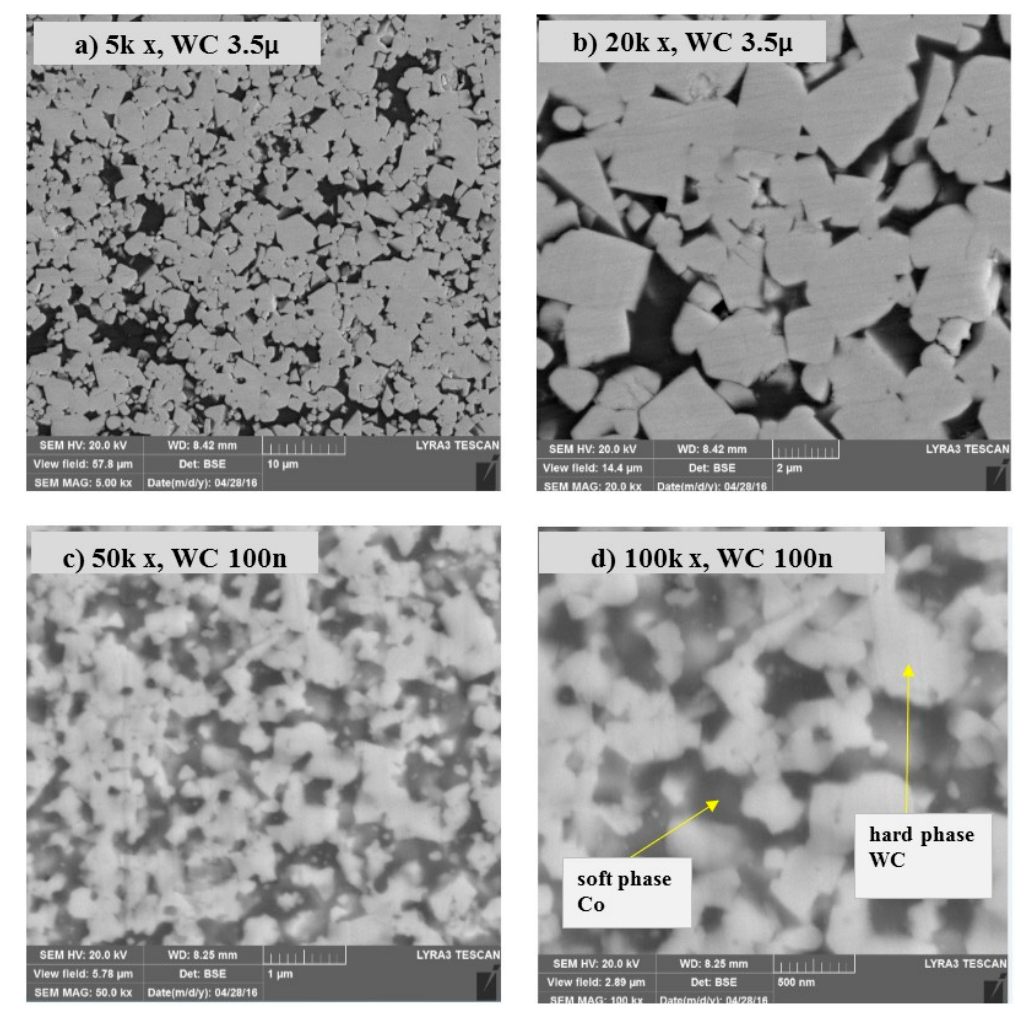
Figure 2. BSE images of samples sintered by SPS ( a , b ) 3.5 μ m WC-9% CO at 45 MPa and 1200 °C and ( c , d ) 100 nm WC-9% Co at 50 MPa and 1250 °C.